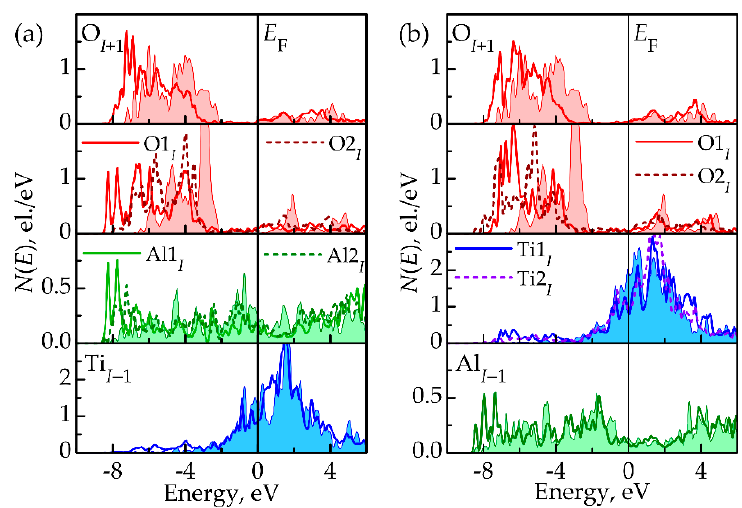
Figure 5. Local DOSs of the interfacial atoms for the hollow configuration at the TiAl / TiO 2 interface: ( a ) Al termination; ( b ) Ti termination. Shaded areas correspond to DOSs of atoms on the clean surfaces of the oxide and the alloy.